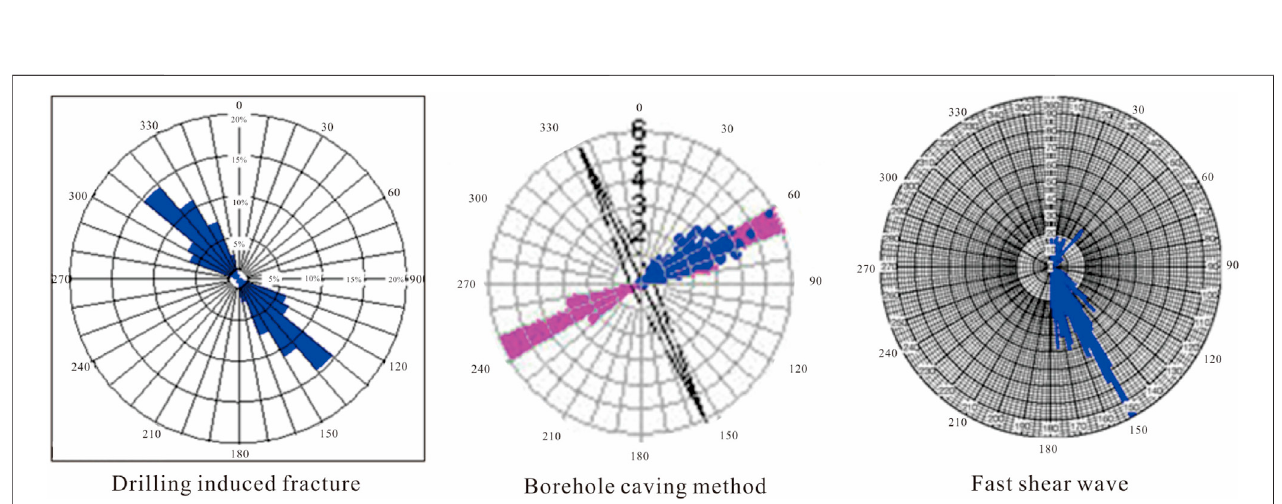
FIGURE 19 | Stress direction identi fi cation of the Lucaogou Formation in the Jimsar Sag.